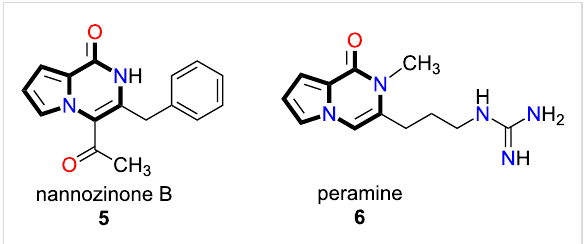
Figure 2: Structures of some natural products containing a pyrrolo- pyrazinone moiety.